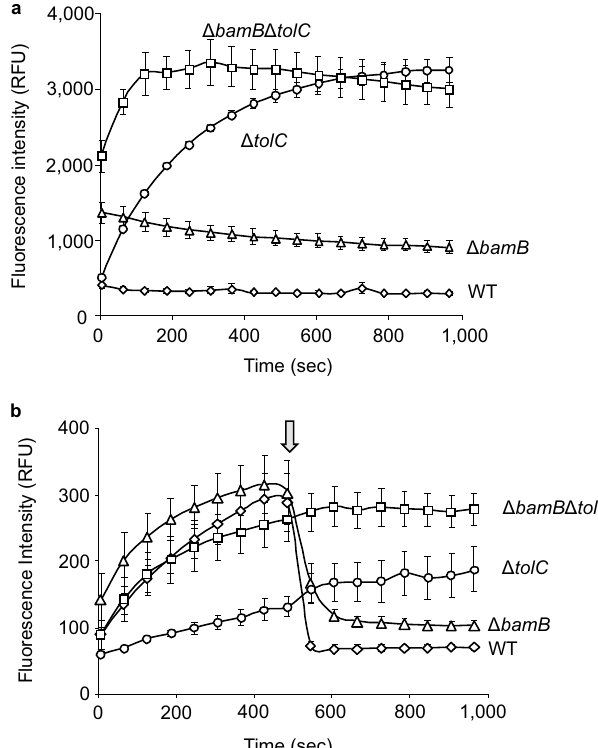
Figure 1. NPN influx and efflux analysis. ( a ) Result of the influx analysis; fluorescence intensity of NPN is presented as a function of time. The data are presented as the mean ± standard error of mean from triplicate experiments. ( b ) Efflux analysis. The arrow indicates the time of glucose addition. NPN, N-phenyl-1- naphthylamine; WT, wild-type strain; Δ bamB , outer membrane lipoprotein deletion mutant; Δ tolC , outer